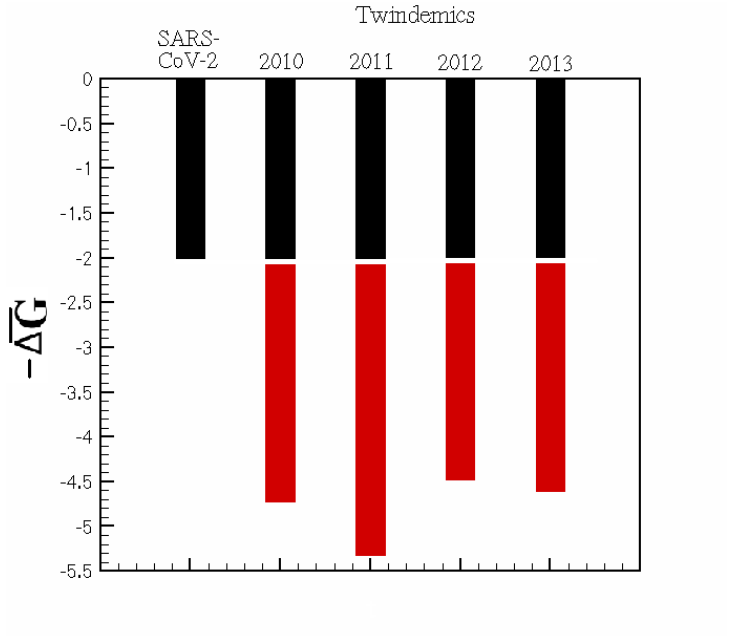
Figure 4. Plot comparing the baseline ¯ ∆ G I for the beginning of the SARS-CoV-2 outbreak and c average ¯ ∆ G I values over an Influenza season while SARS-CoV-2 is overlaid with a distinct viral c pathogen corresponding to infectiousness gathered during the Influenza season beginning 2010, 2011, 2012, and 2013. Black bars indicate the baseline ¯ ∆ G I for SARS-CoV-2 outbreak. Red bars indicate the c increasing spontaneity into the infected bin when the epidemics occur